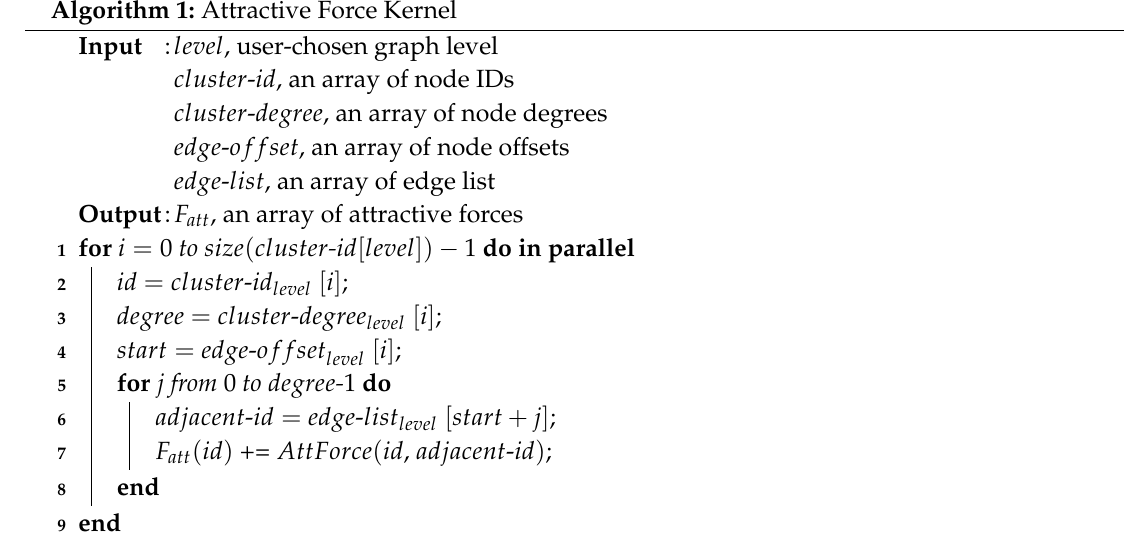
Algorithm 1: Attractive Force